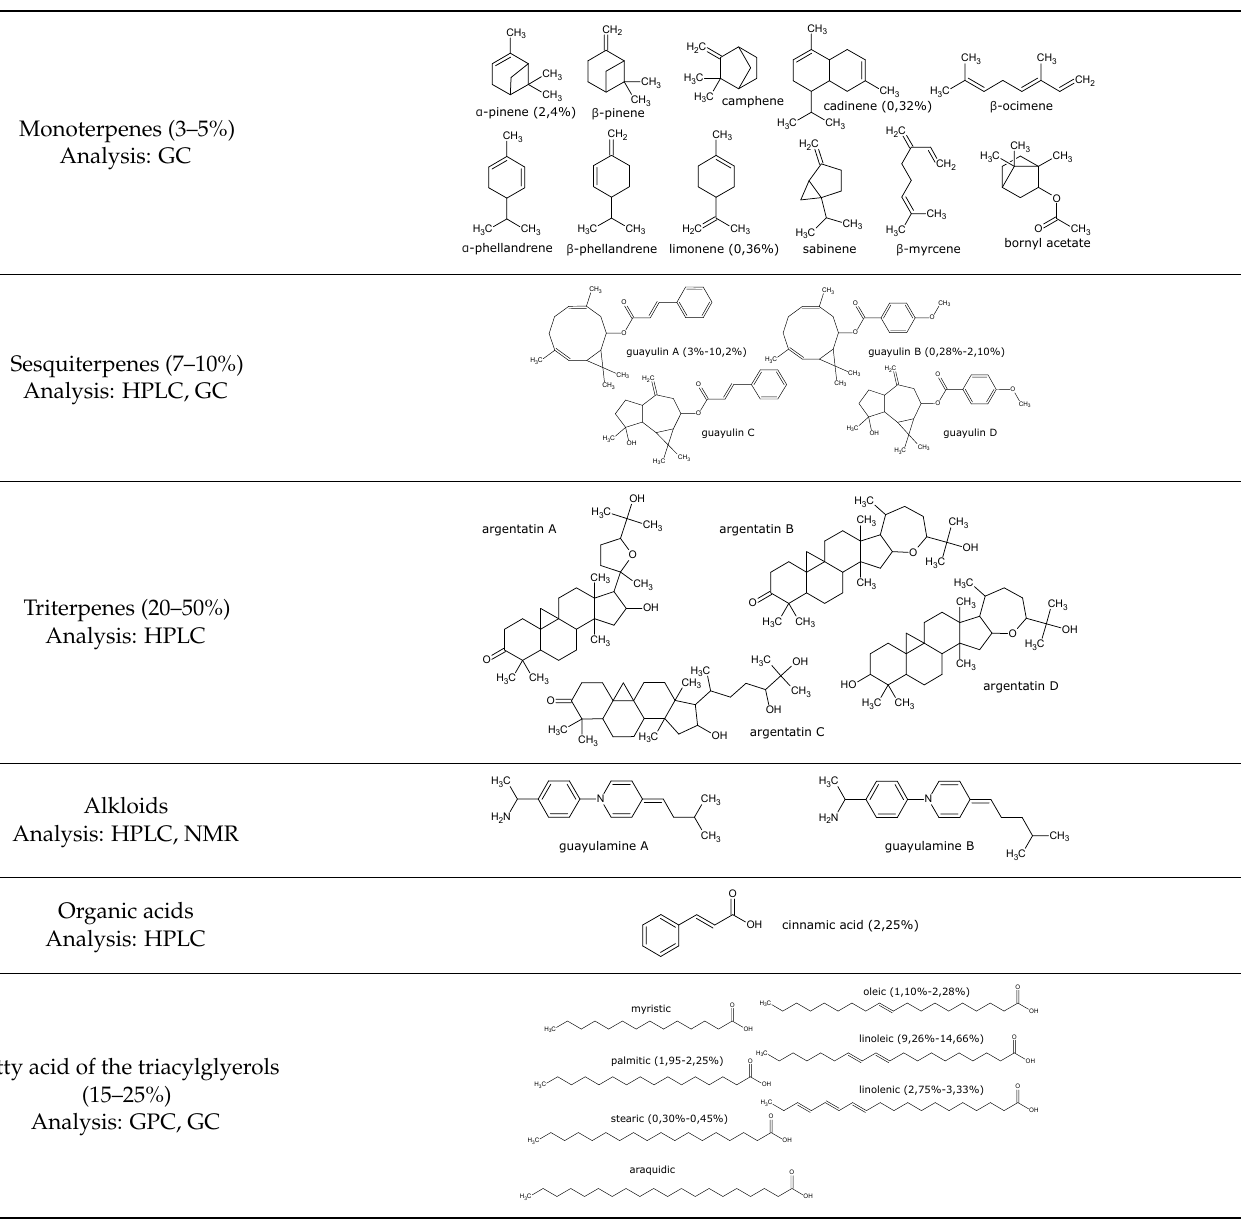
Table 1. Most representative molecules in guayule